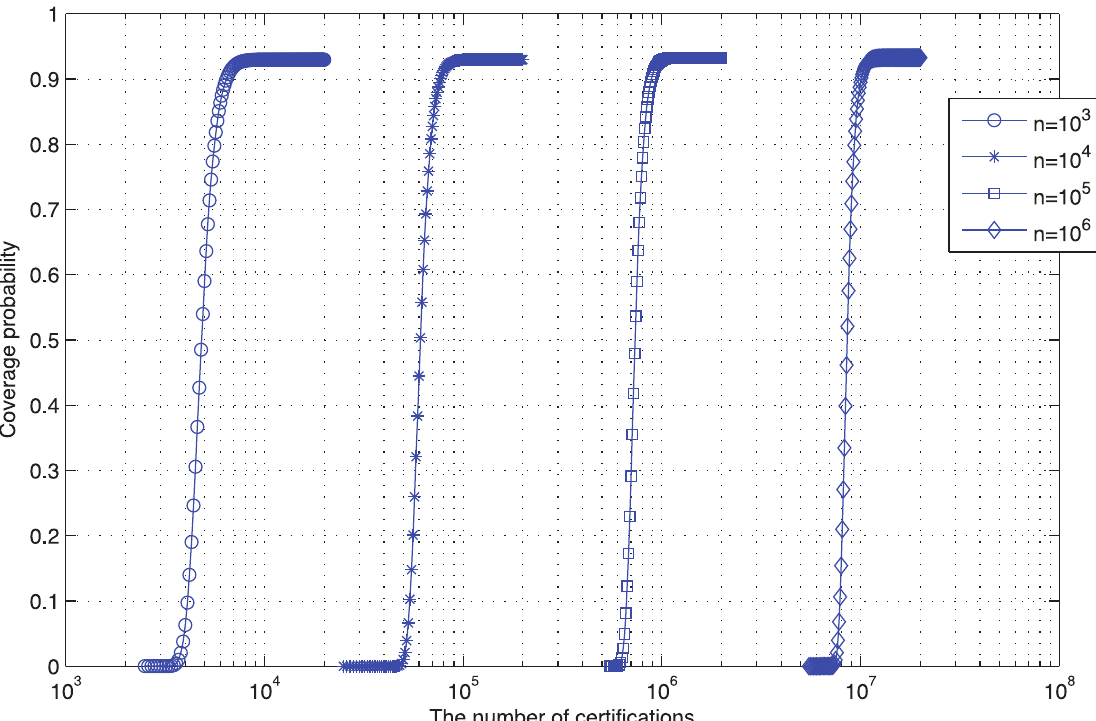
Figure 1. Under different network size, the probability changes with the increasing of l . By formula (17), where ~ cc ~{ nW ( { 2 d e { 2 d ) , d ~ l = n , the Coverage Probability changes with the increasing of l under different network size.